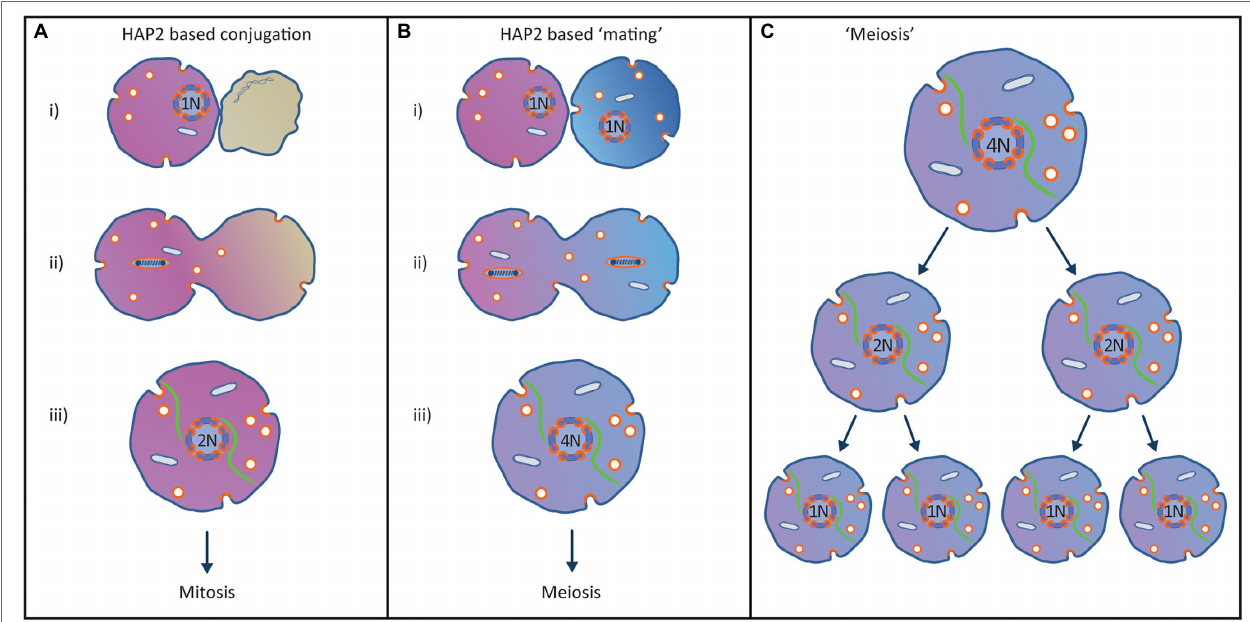
FIGURE 5 | Proposed origin of the eukaryotic sexual cycle from a HAP2-based conjugation process to co-transfer virus and mitochondrion to new hosts. (A) Horizontal transmission virus/endosymbiont to new hosts. (i) Superorganism encounters suitable host cell and recognizes that it is not infected with the virus. (ii) Prior to conjugation the viral genome replicates and condenses in preparation for fusion with the new host. The plasma membranes of the two cells subsequently fuse using the HAP2 fusion protein used by the virus in its standard infection cycle. (iii) After complete fusion of the cells, the viral factory is re-assembled, and the viral factory is centred in the cell using the tubulin cytoskeleton. The 2 N viral genome can enter a single mitosis-like cell division controlled by the viral copy number control system that maintains the viral genome at 1 N. (B) Origin of the eukaryotic sexual cycle. (i) Two divergent but closely related superorganisms recognise each other as a potential host but fail to recognise the other host is already infected by a closely related virus. This results in both superorganisms initiating the conjugation process. (ii) Prior to conjugation, the viral genomes replicate and condense in preparation for transfer to new hosts and the plasma membranes of the two cells fuse using the HAP2 fusion protein encoded by the virus. (iii) After complete fusion of the cells, the viral factories are re-assembled, and the viral factories are centred in the cell using the tubulin cytoskeleton. The two 2 N viral factories fuse to create a single 4 N viral factory containing two homologous pairs of viral chromosomes. (C) Due to the copy number control mechanisms evolved by the virus to maintain a low copy number, the 4 N viral genome must enter two mitosis-like cell divisions without viral genome replication to reduce the viral genome back to 1 N, resulting in completion of a primitive eukaryotic sexual